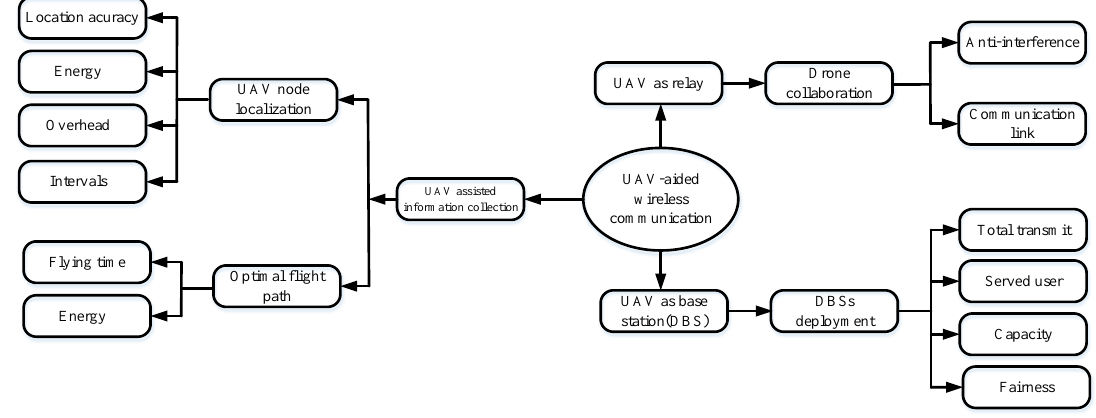
Figure 6. UAV-aided wireless networks.